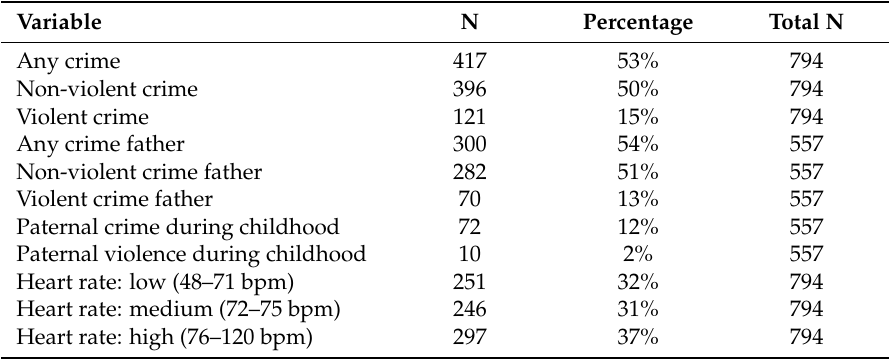
Table 1. Descriptive statistics of all variables used in the analyses.